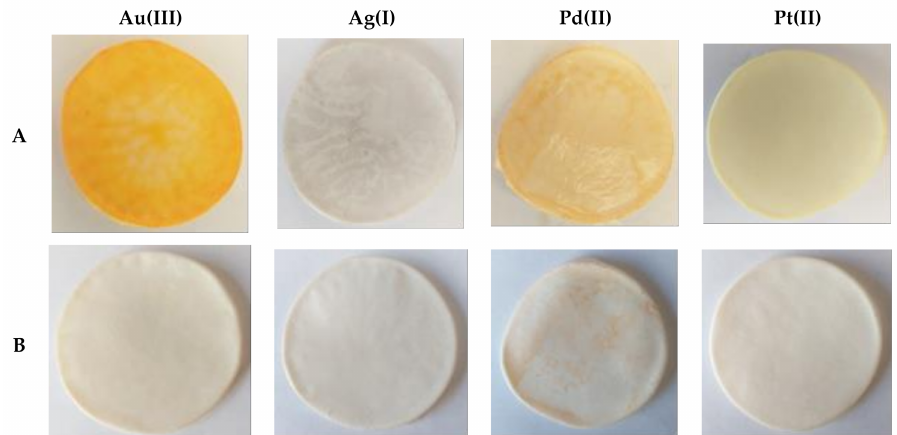
Figure 7. The polymer inclusion membranes containing 2,6-bis(4-methoxybenzoyl)-diaminopyridine after processes: membrane extraction ( A ), membrane back-extraction ( B ).